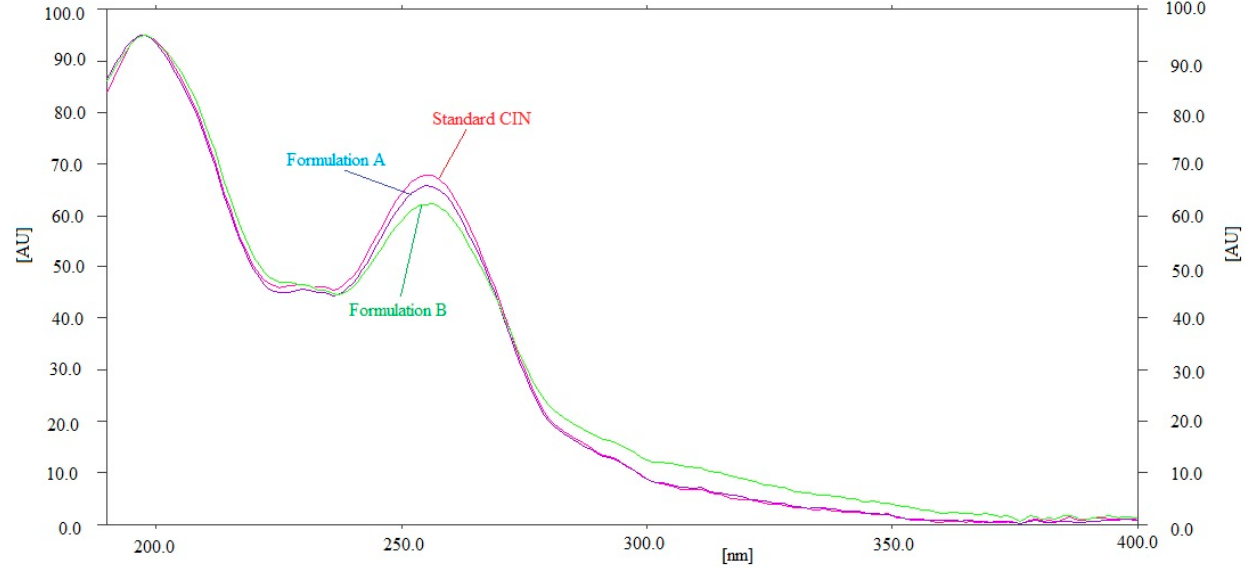
Figure 4. Overlaid UV absorption spectum of pure CIN and commercial formulations.